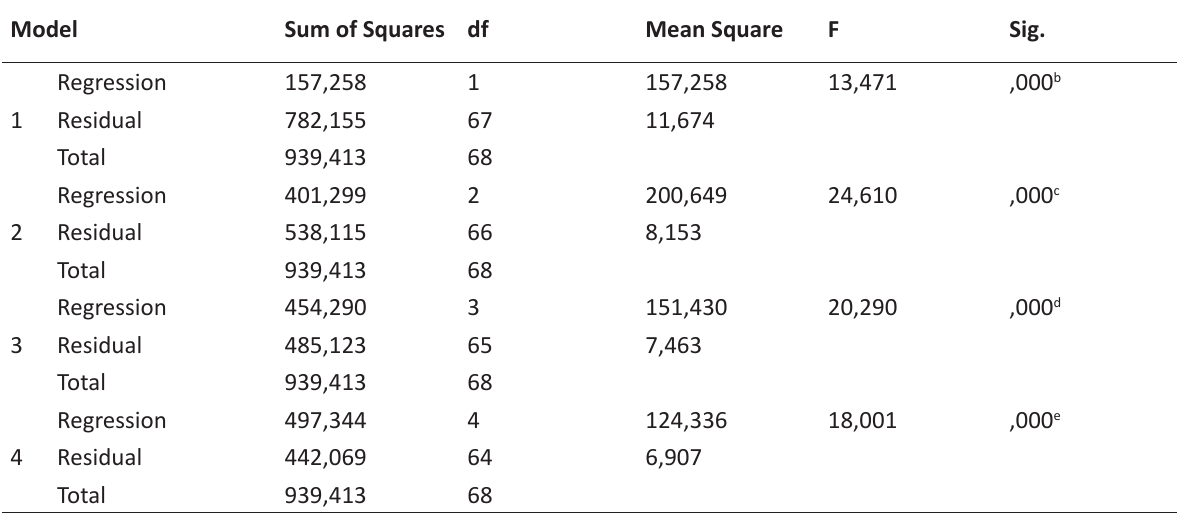
Table 3. Anova test evaluated of regression analysis for estimation of fat% Model Sum of Squares df Mean Square